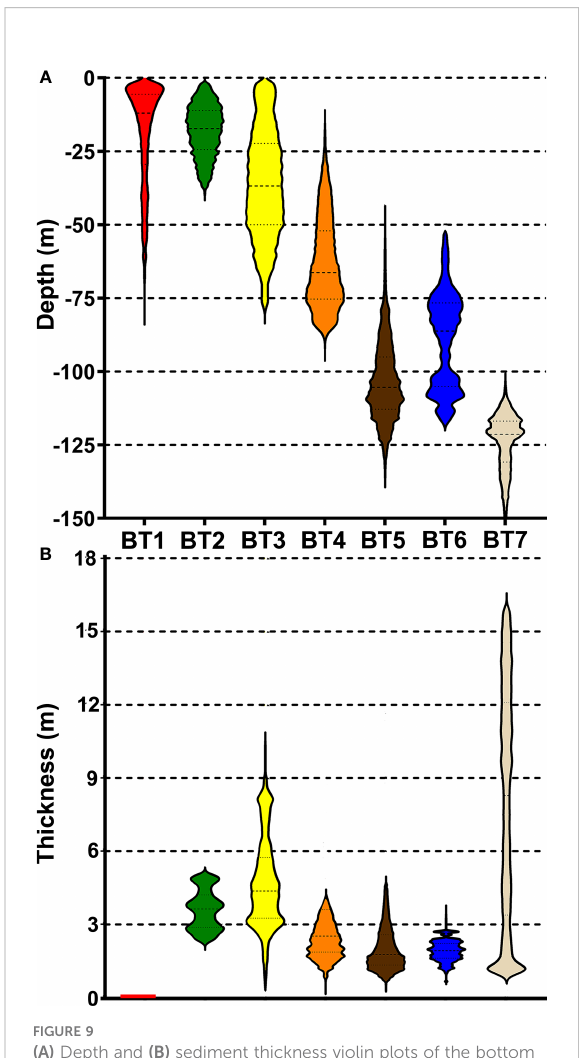
FIGURE 9 (A) Depth and (B) sediment thickness violin plots of the bottom types mapped at Gyaros sea fl